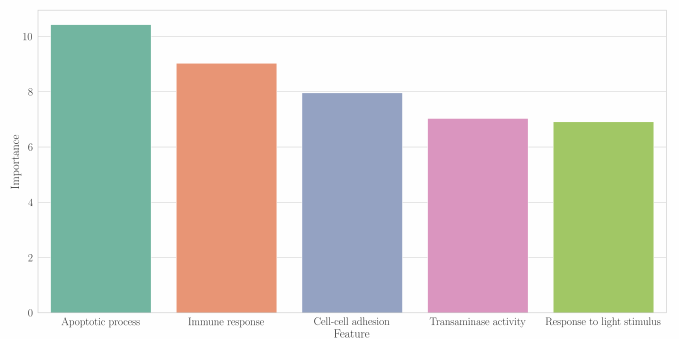
Figure 3. Example of a global explanation for the Gene ontology.